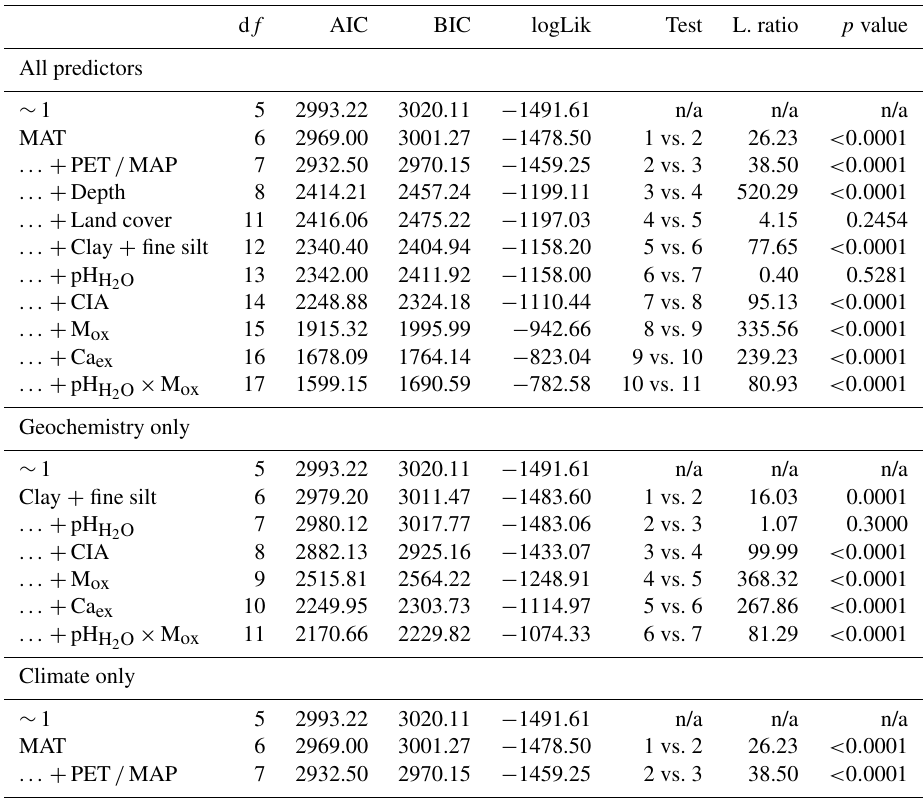
Table B4. Analysis of variance (ANOVA) summary for linear mixed-effects analyses with the entire data set ( n = 1601), including all predictors and geochemistry-only and climate-only predictors. Fixed effects were added using a step-wise method. The first entry ( ∼ 1) refers to the constant null model,